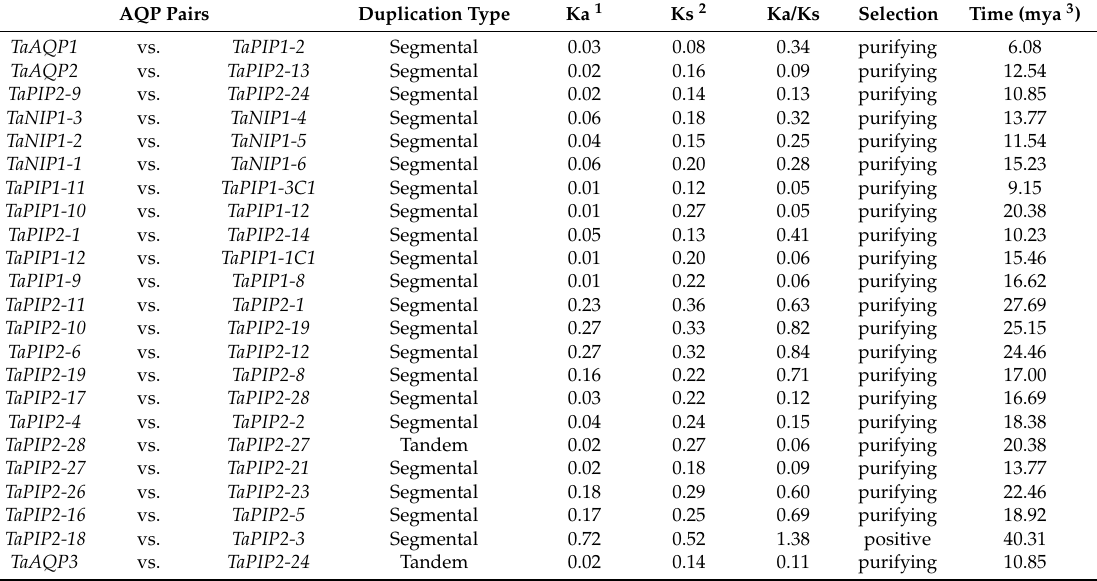
Table 1. Evolutionary parameters for duplicated AQP genes. Table shows Ka/Ks ratios, duplication and selection types and time of